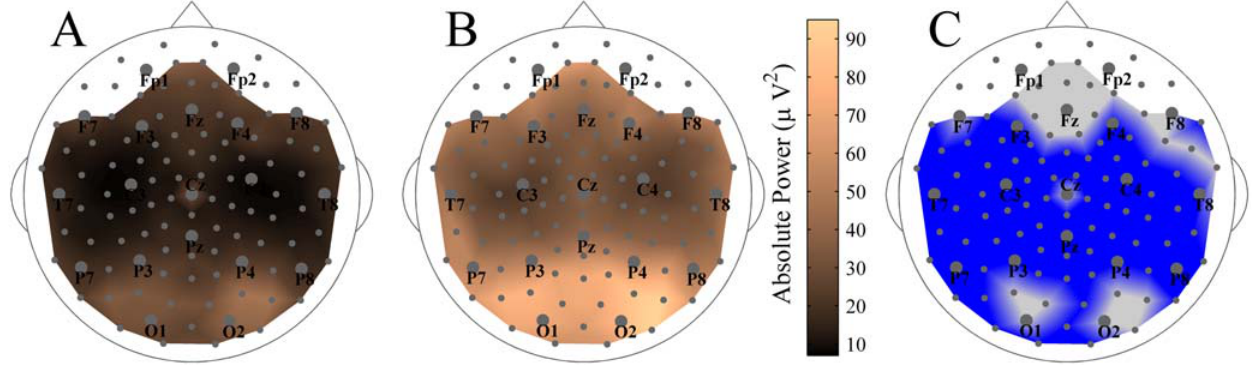
Figure 6. Whole-head power maps for SZ patients and normal controls. The group-averaged maps of absolute power for the broad-band resting EEG are shown for patients (A) and for controls (B). C: Difference map (Patients vs. Controls). In the blue regions the absolute power in patients is significantly lower than that in controls. There are no significant differences in the gray regions.